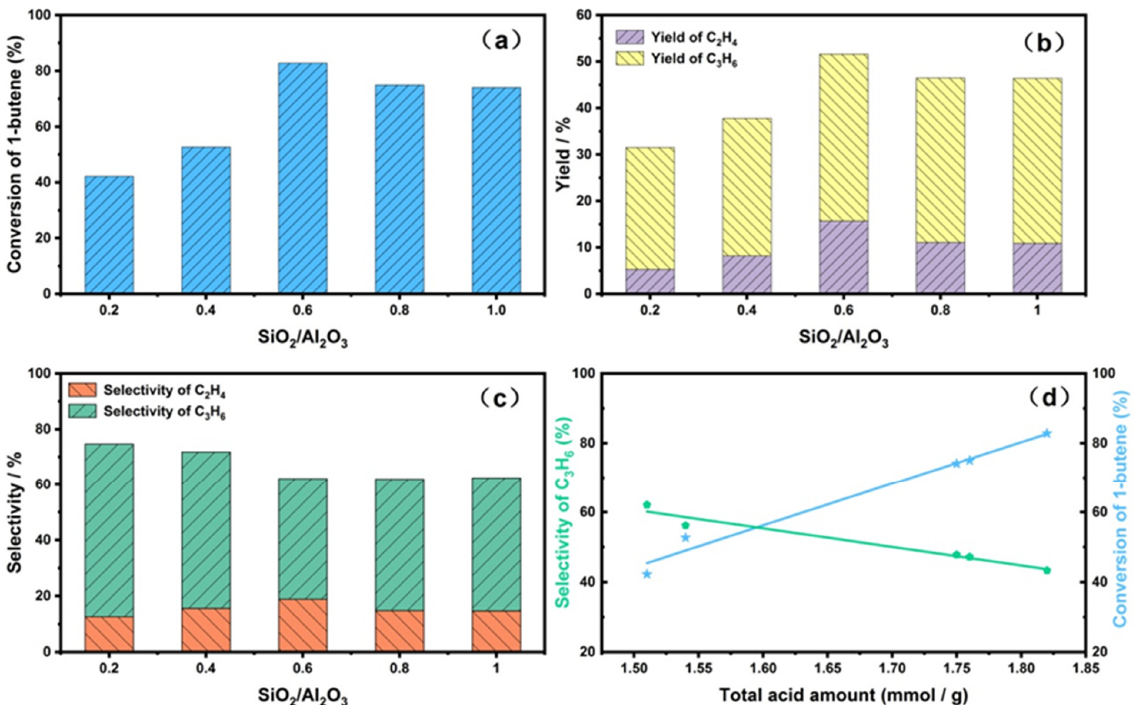
Figure 6. ( a ) Conversion of 1-butene; ( b ) Yield of ethene, propene; ( c ) Selectivity of ethene, propene a function of the SiO 2 /Al 2 O 3 over as-synthesized SAPO-34 zeolite catalysts; ( d ) Selectivity of propene and conversion of 1-butene as a function of total acid amount over as-synthesized SAPO-34 zeolite catalysts. Table 4. Product distribution of 1-butene catalytic cracking over as-synthesized SAPO-34 samples. Catalysts